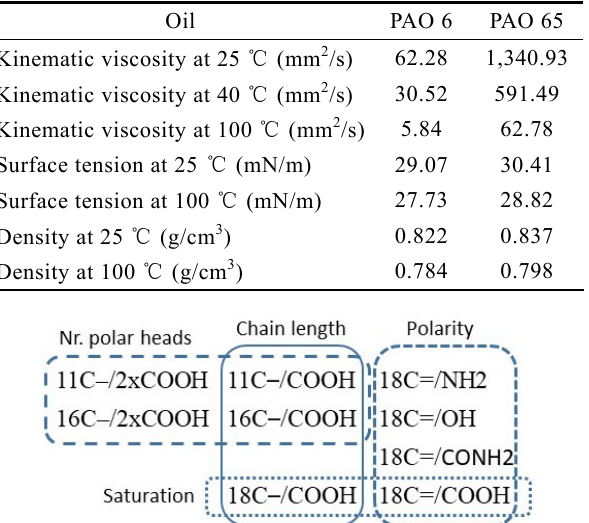
Table 2 Kinematic viscosity, surface tension, and density of selected base oils.